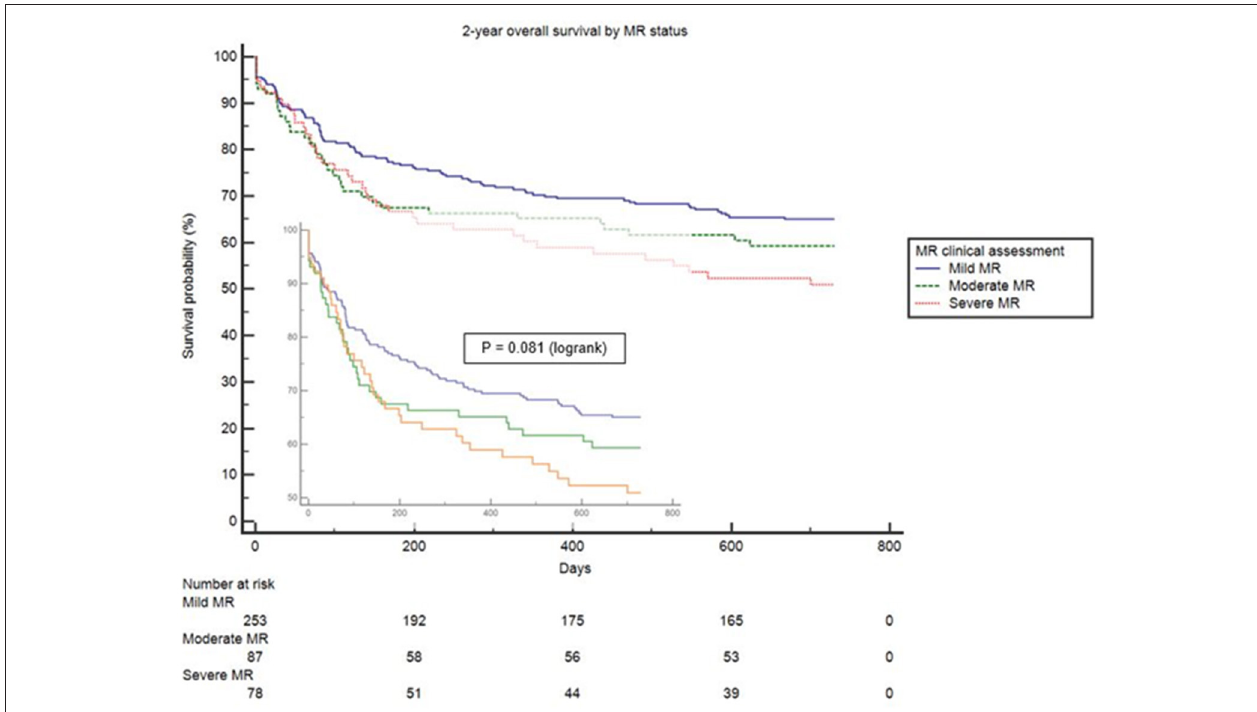
FIGURE 3 | Survival curves of 2-year all cause mortality comparing mild, moderate and severe MR.